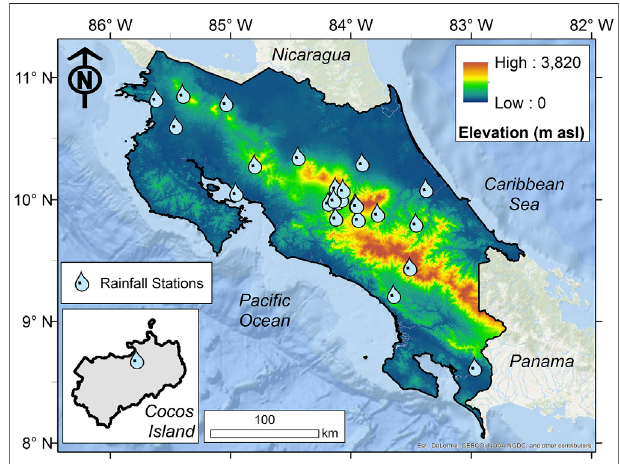
FIGURE 2 | Continental and maritime rainfall isotope monitoring sites acrossCosta Rica. (A) The waterdrop symbolrepresents rainfallstations(N (cid:2) 5,905) operated since early 2013. Cocos Island (inset) is located ∼ 580 km S-SW from the Paci fi c coast of Costa Rica (Corrales-Salazar et al., 2016), representing a maritime domain with limited orographic relief. Figure adapted using data from Sánchez-Murillo and Birkel (2016) and Corrales- Salazar et al.